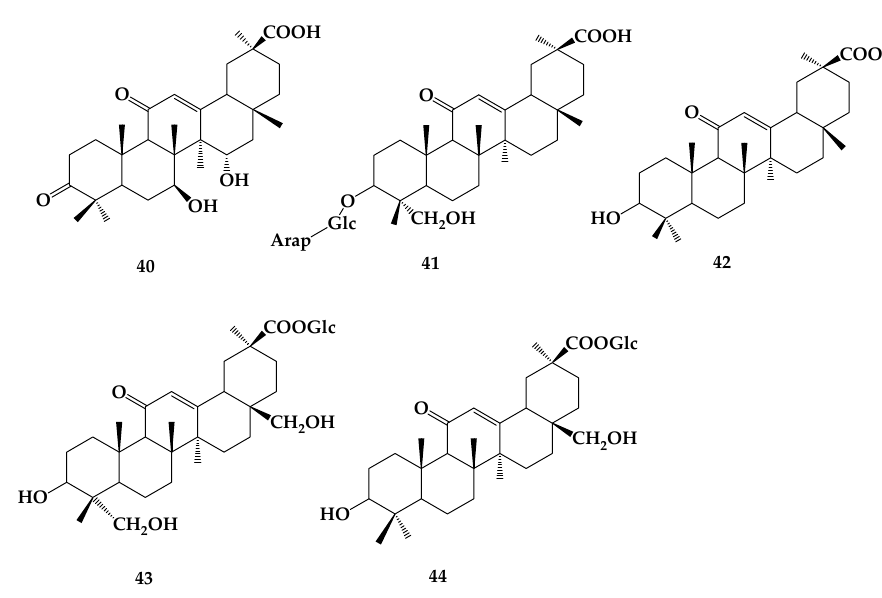
Figure 10. The chemical structures of compound 40–44.